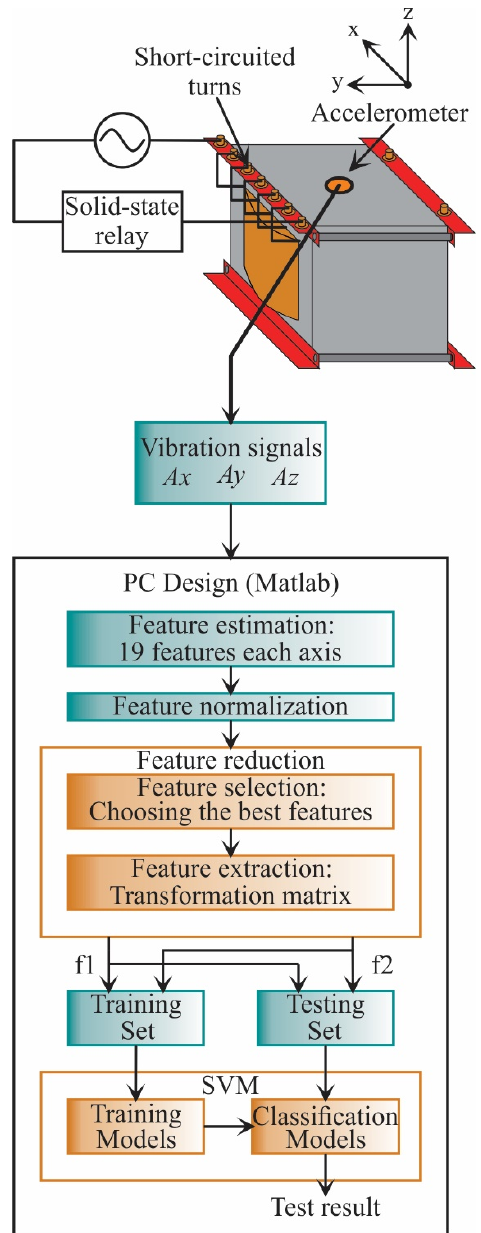
Figure 4. Flowchart for the proposed methodology during the design stage.